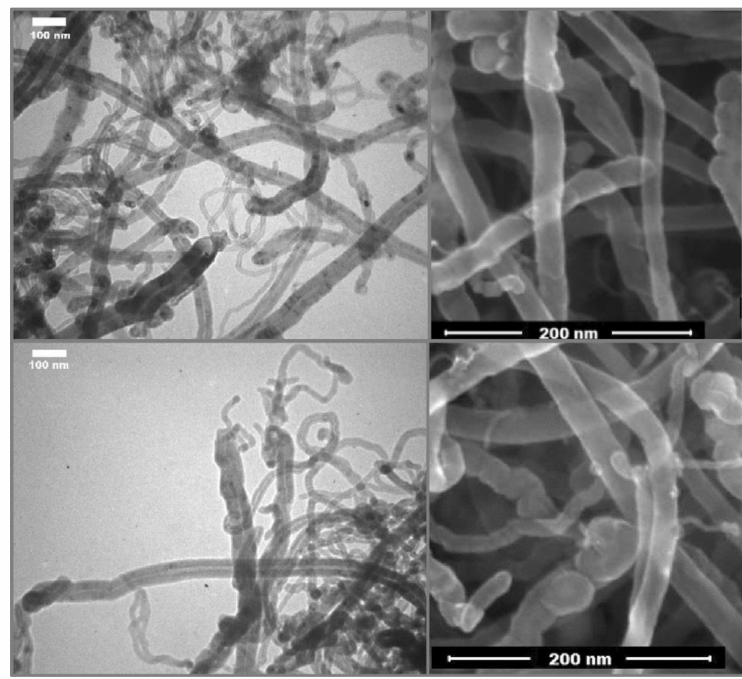
Figure 28. TEM and SEM images (on left and right, respectively) of the MWCNT and MWCNT-400 samples (top and bottom panels, respectively) (reproduced with permission from [307]. Copyright 2017 WILEY-VCH Verlag GmbH & Co.